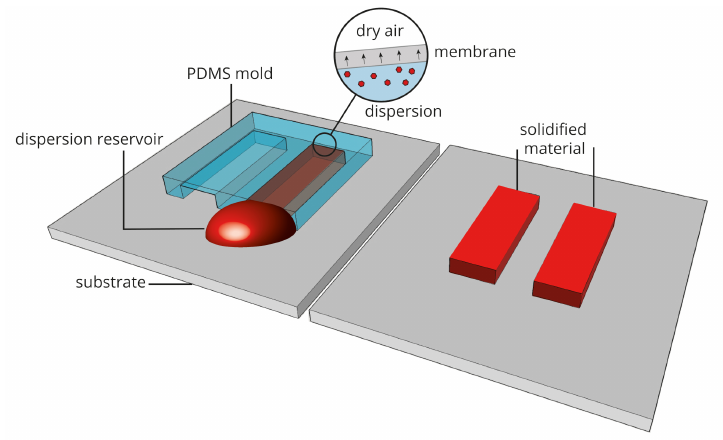
Figure 9. Sketch of the µ -pervaporation technique leading to micro-structured deposits: A poly(dimethyl siloxane) (PDMS) mould ( left ) is designed with channels initially filled with a dilute dispersion; solvent spontaneously permeates across the elastomer, concentrates the nanoparticles, and leads to a solid material out of the dispersion upon removal of the mould ( right